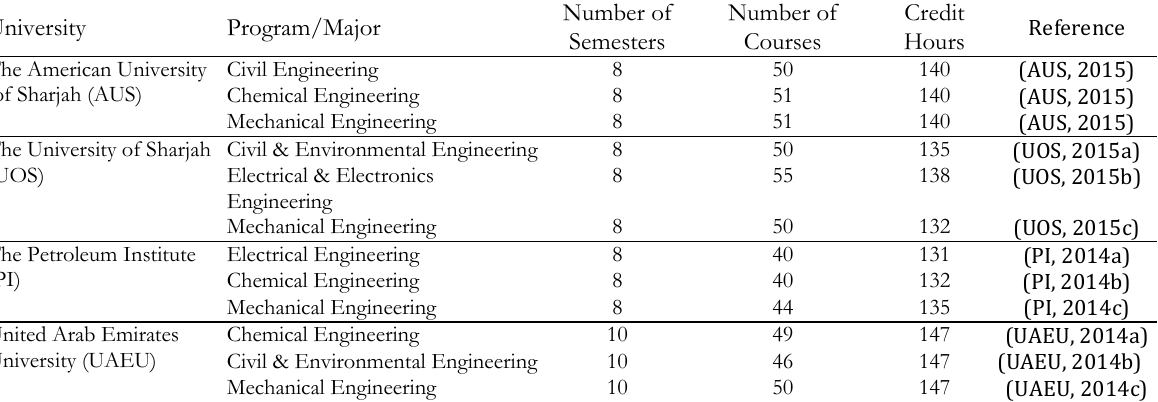
Table 3. Summary of selected engineering curricula from universities in the